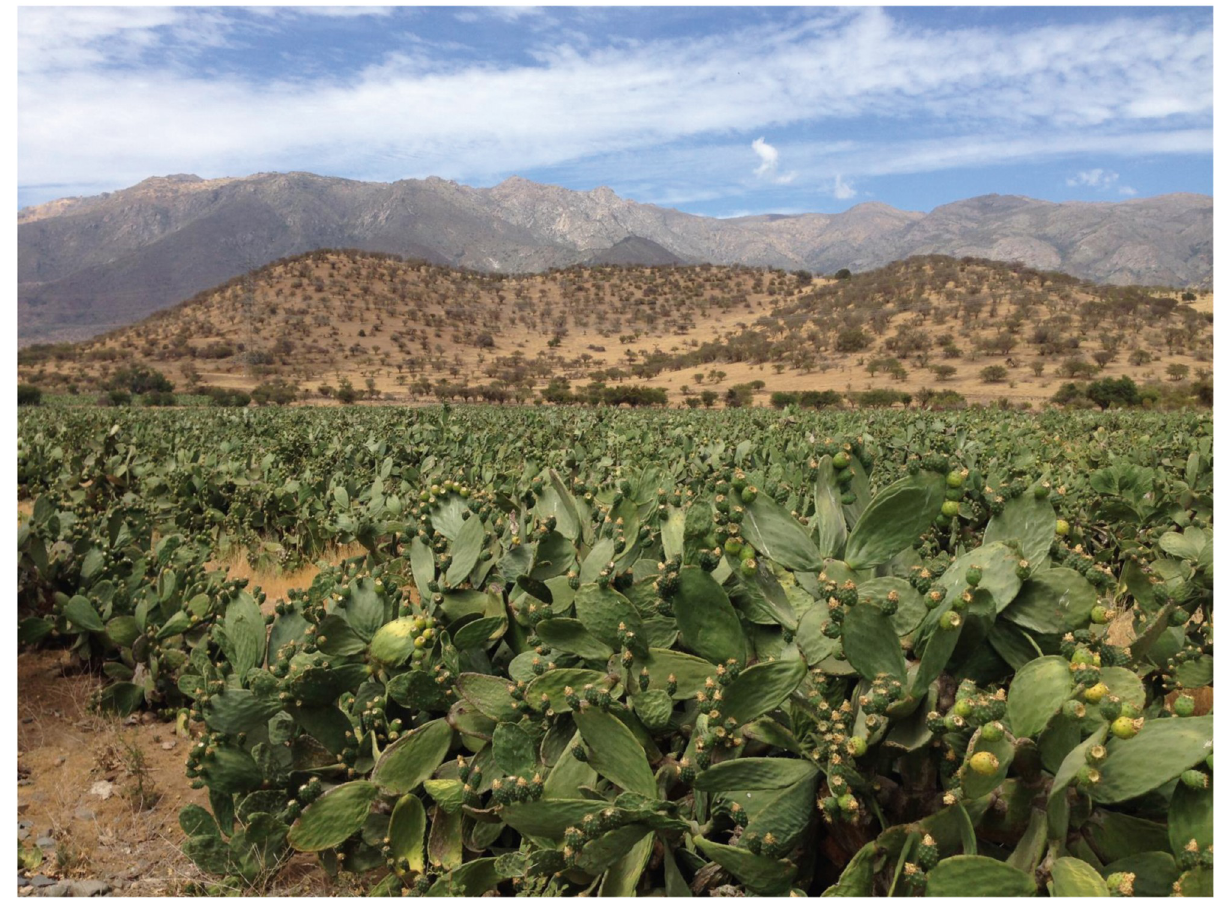
Fig 4. The prickly pear orchard ( Opuntia ficus-indica ) examined in this study. The orchard is located in Til-Til, 2 km away from the grape orchard shown in Fig